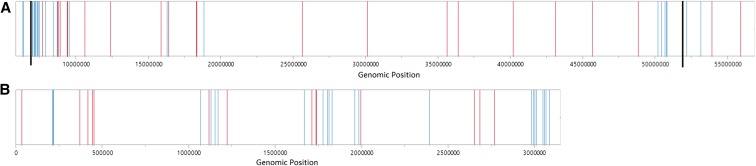
Genomic positions of candidate resistance genes within the two resistance loci. The bars represent the starting location for the annotated transcript of the candidate genes on (A) the locus on chromosome 7, and (B) the locus on chromosome 9. A red bar indicates an R-gene while a blue bar indicates a defense-related gene that is not an R-gene. The thick vertical black lines on the chromosome 7 locus indicate the size reduction of this QTL based on Figure 5. The x-axis represents the genomic position within each chromosome. The x-axes in A and B differ in scale.